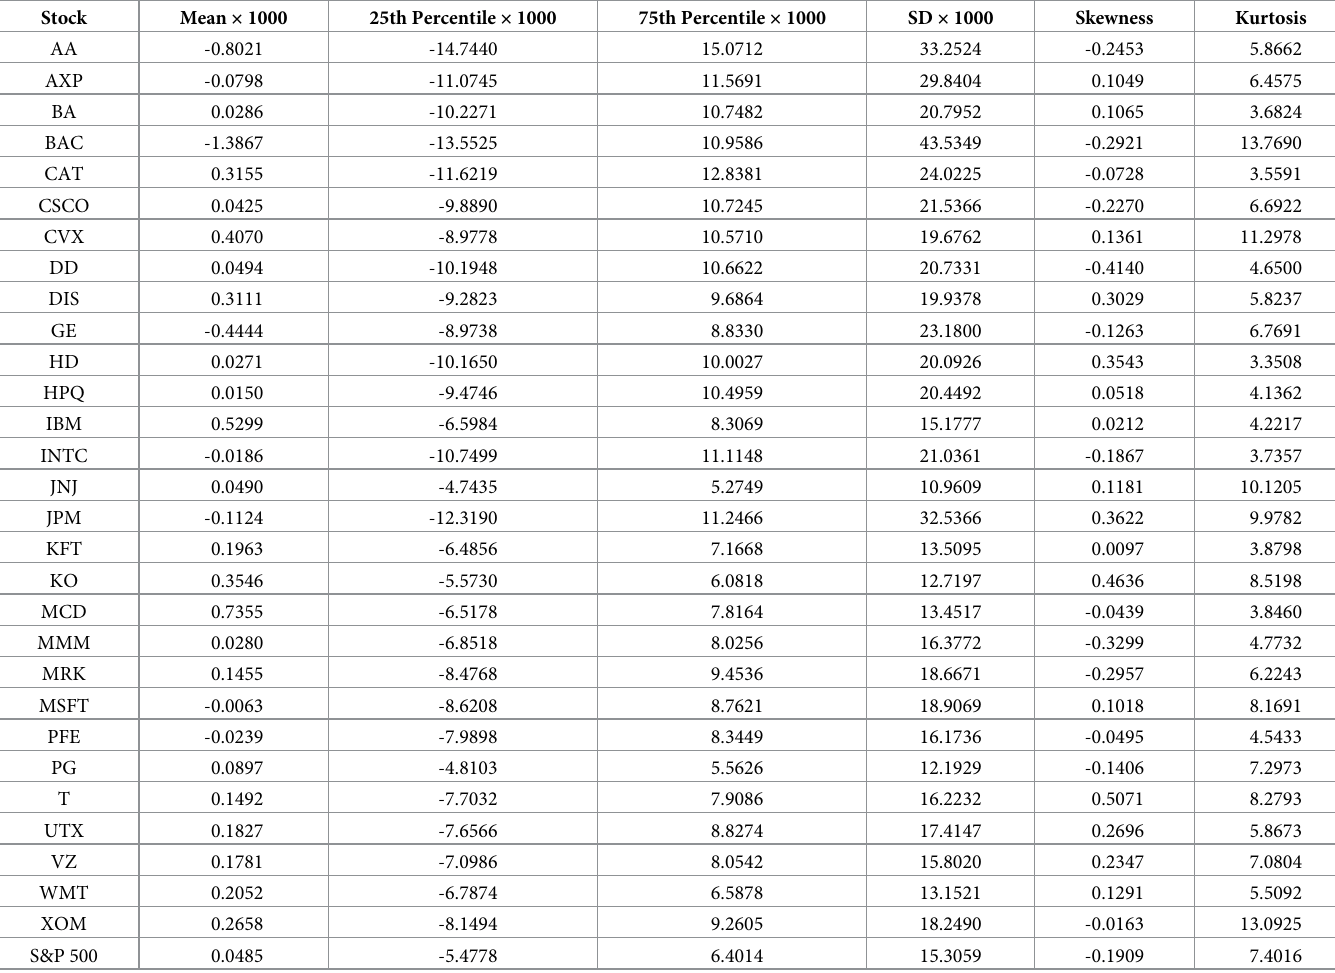
Table 2. Descriptive statistics for daily